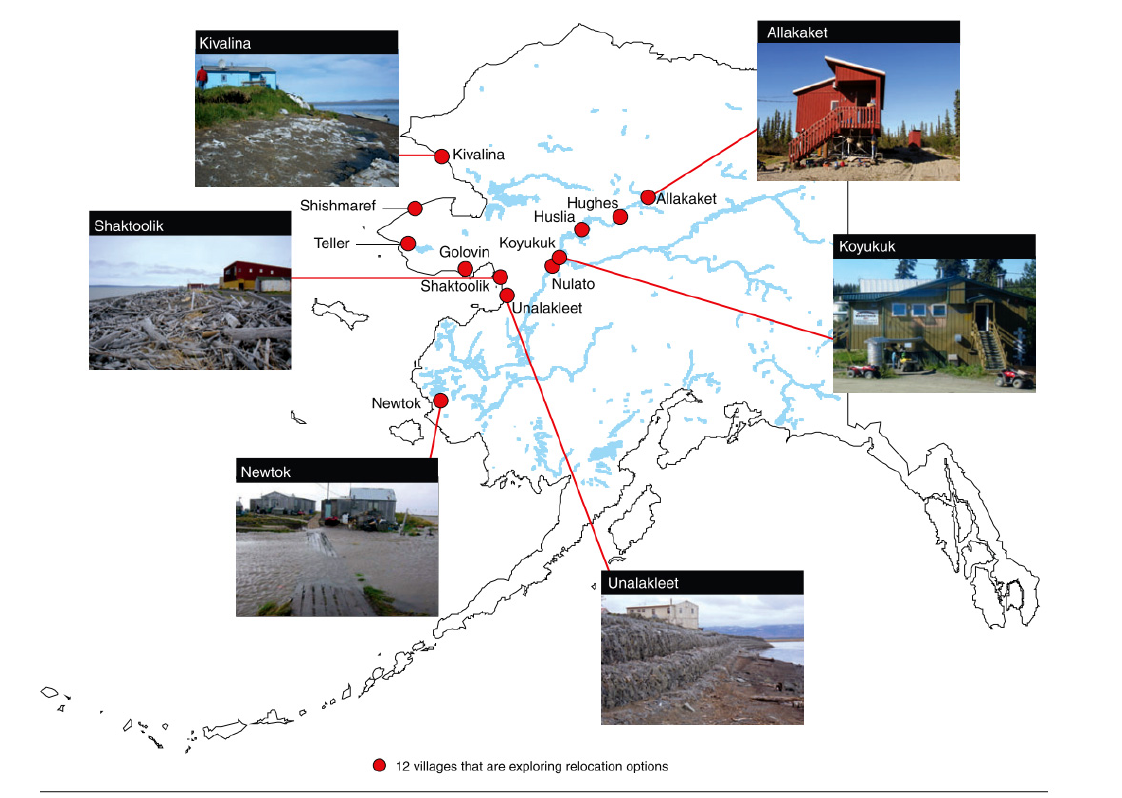
Fig. 1. Twelve Alaska Native villages that are seeking to